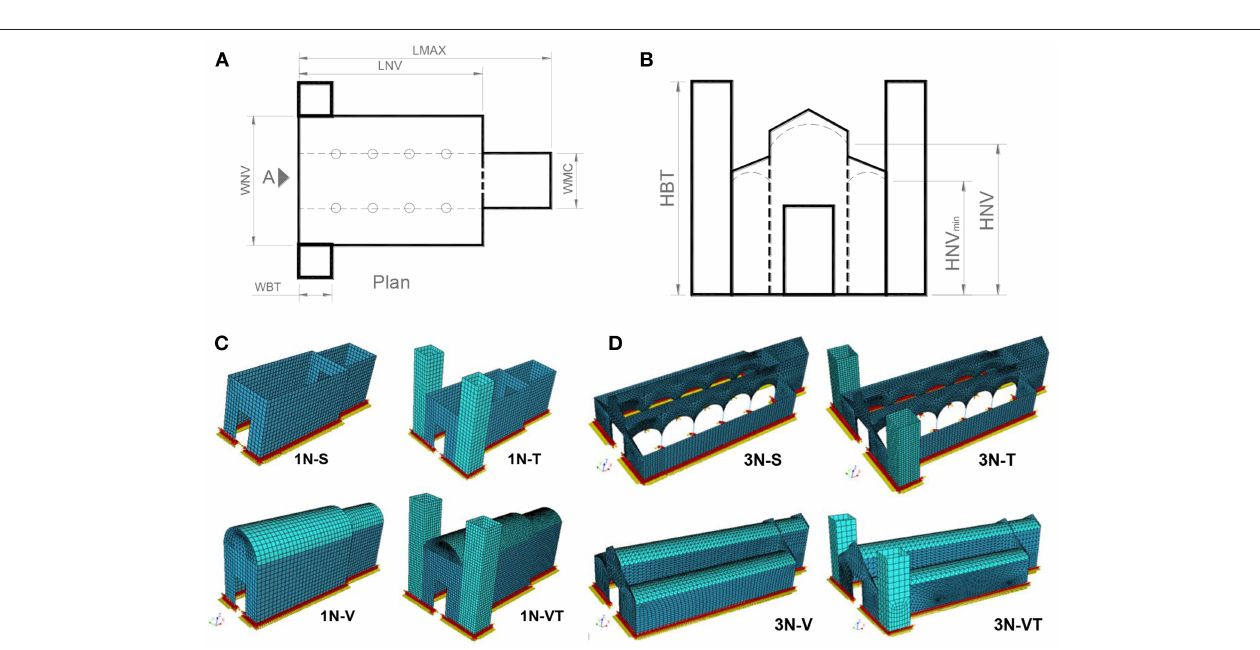
FIGURE 3 | Geometric parameters in (A) plan and (B) in elevation, and views of the implemented numerical models for (C) single nave type and (D) three naves type.